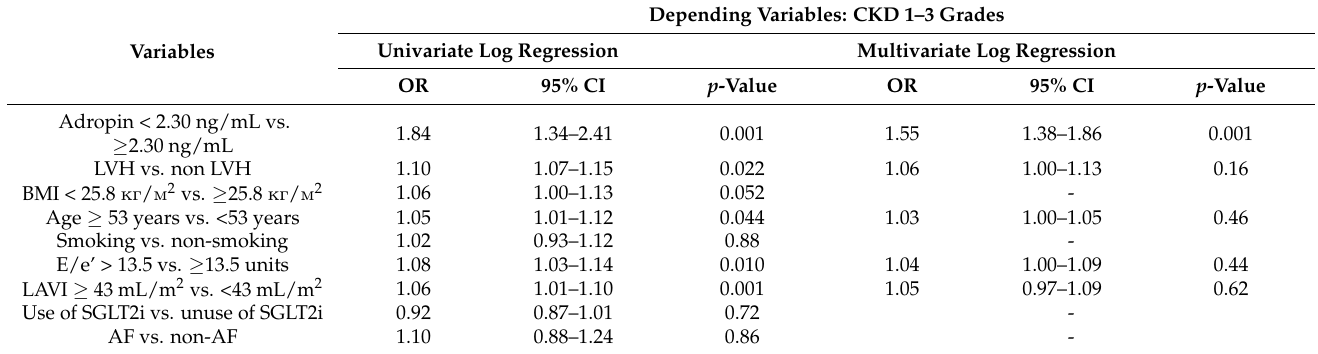
Table 2. Predictors for CKD in the T2DM HF population. The results of the univariate and multivari- ate logistic regression analyses were adjusted for